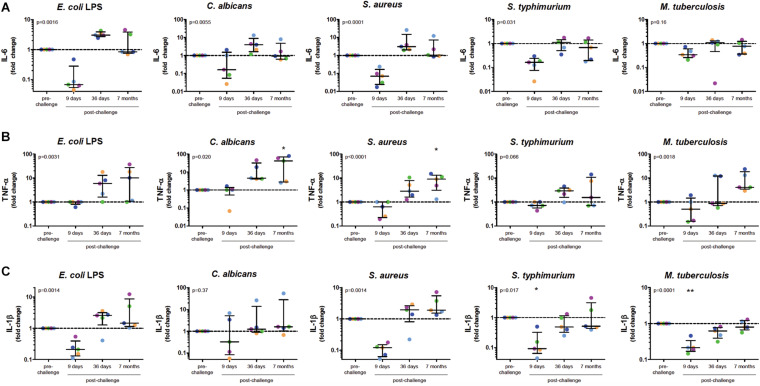
Monocytes after Controlled Human Malaria Infection Show Trained Innate Immune Memory Phenotype. Monocytes at baseline (before infection), 9 days after CHMI challenge, 36 days after challenge and 7 months after challenge, were isolated from PBMC and stimulated for 24 h with LPS, C. albicans, S. aureus, S. typhimurium, or M. tuberculosis. Graphs show supernatant IL-6 (A), TNF-α (B), and IL-1β (C) concentrations determined by ELISA as fold change over the baseline measurements. Dots represent individual volunteers (colors represent each volunteer). P-values shown are the results of Friedman Repeated Measures ANOVA. If time points differed significantly from baseline after correction for multiple testing using Dunn’s Multiple Comparison Test this is indicated above the appropriate column. *p < 0.05, **p < 0.01.